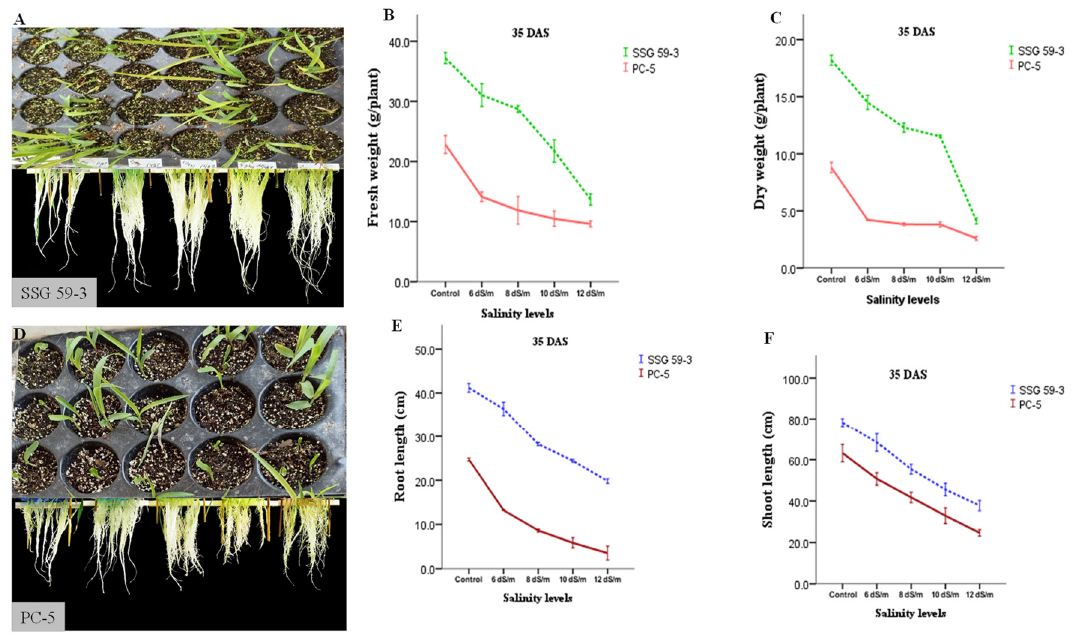
Figure 3. Biomass accumulation and performance of two S. bicolor genotypes—SSG 59-3 (salt-tolerant) and PC-5 (salt-sensitive)—under normal (control) and salt-stressed conditions. ( A ) Twenty-one-day-old seedlings and roots of salt-tolerant SSG 59-3 after 48 h of salt exposure. Effect of the salt treatment on ( B ) Fresh weight (FW), ( C ) dry weight (DW), ( D ) 21-day-old seedlings and roots of salt-sensitive PC-5 after 48 h of salt exposure, ( E ) root length, and ( F ) shoot length. All values are the means ± SD of three biological replicates.